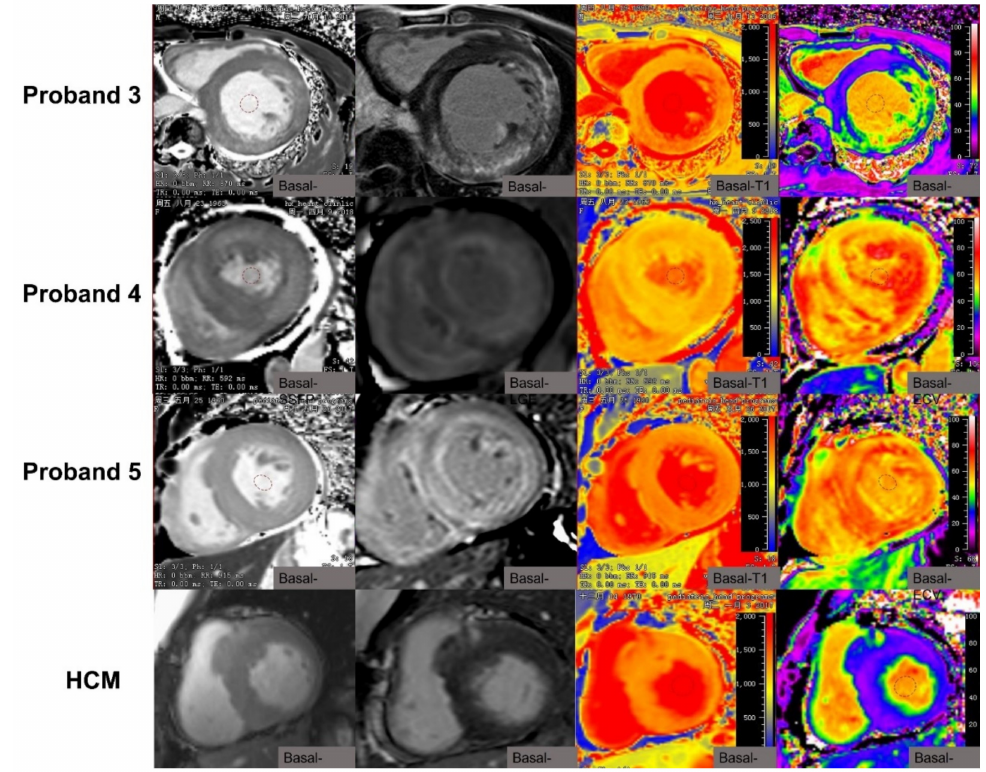
Figure 3. The characteristics of cardiac MRI in the proband 3 patient with PSKAG2 syndrome, the proband 4 patient with senile systemic amyloidosis, and the proband 5 patient with TTR , and a HCM patient with the typical HCM LGE